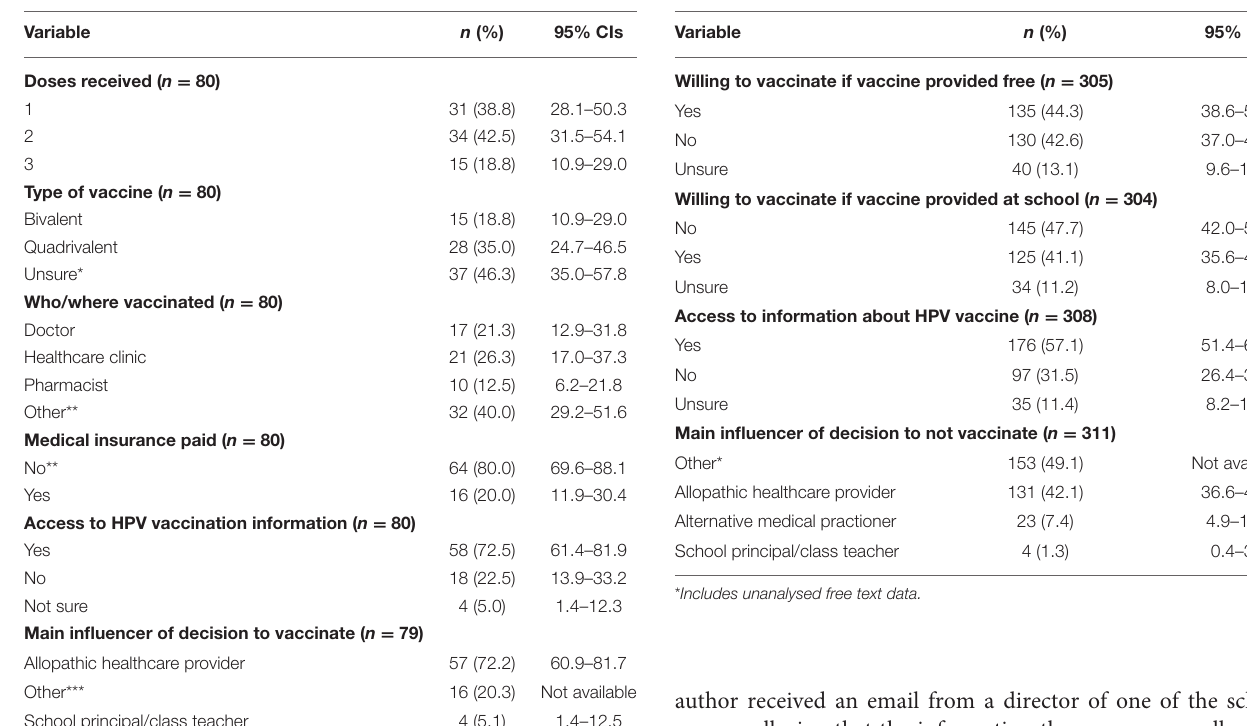
TABLE 7 | Practices of caregivers of unvaccinated girls ( n =